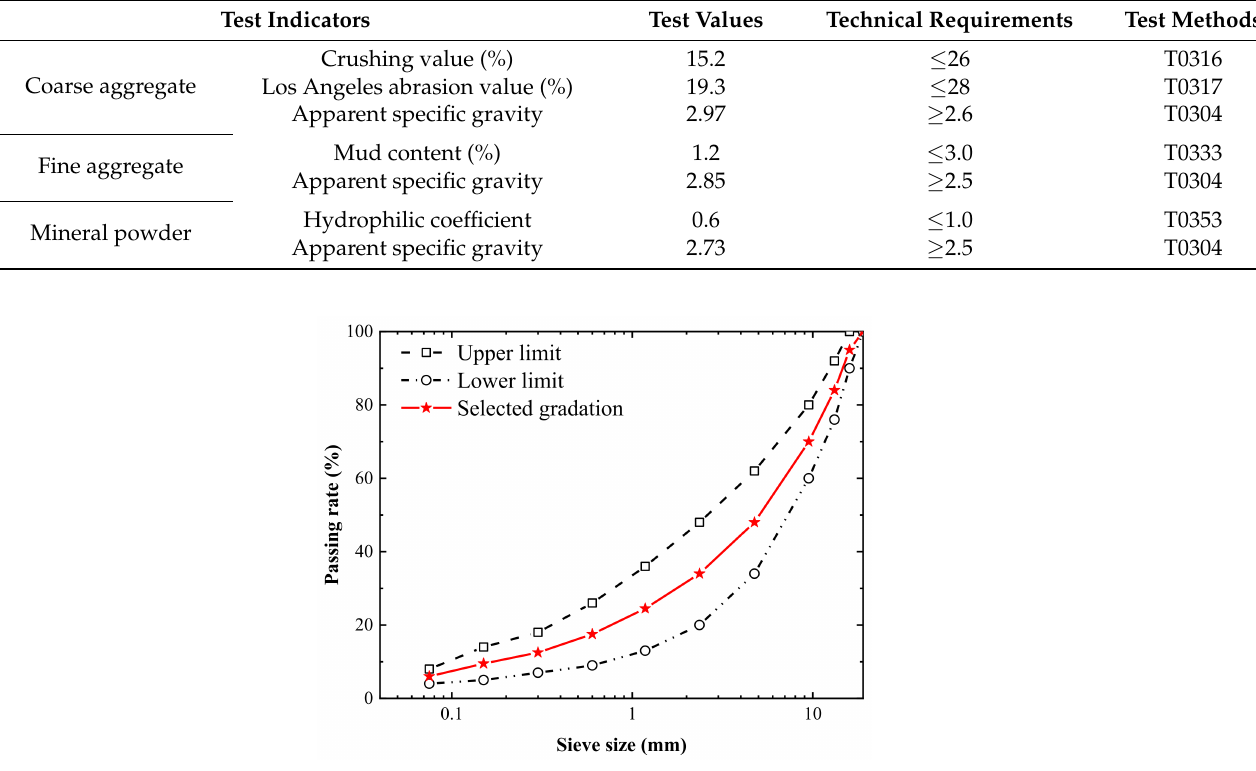
Figure 1. Gradation curve of